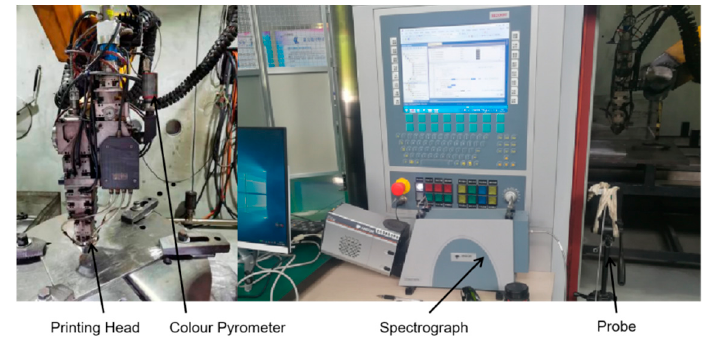
Figure 8. Printing environment and instrument composition.